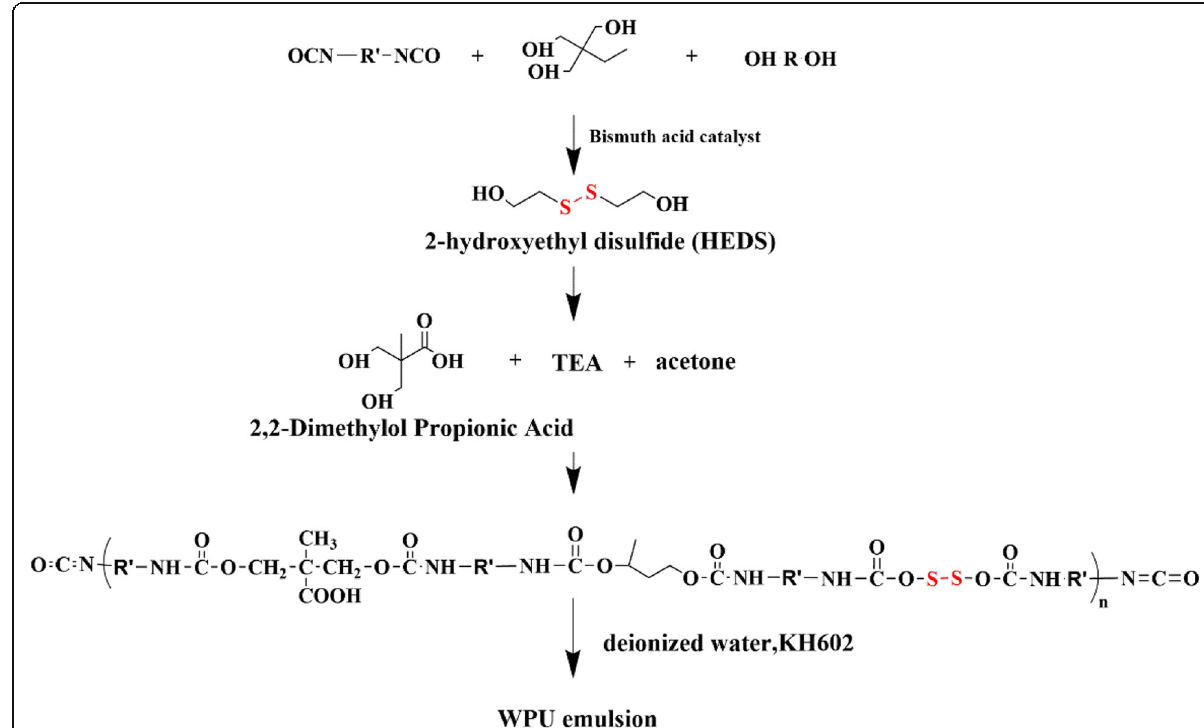
Fig. 2 Synthesis of self-healing waterborne